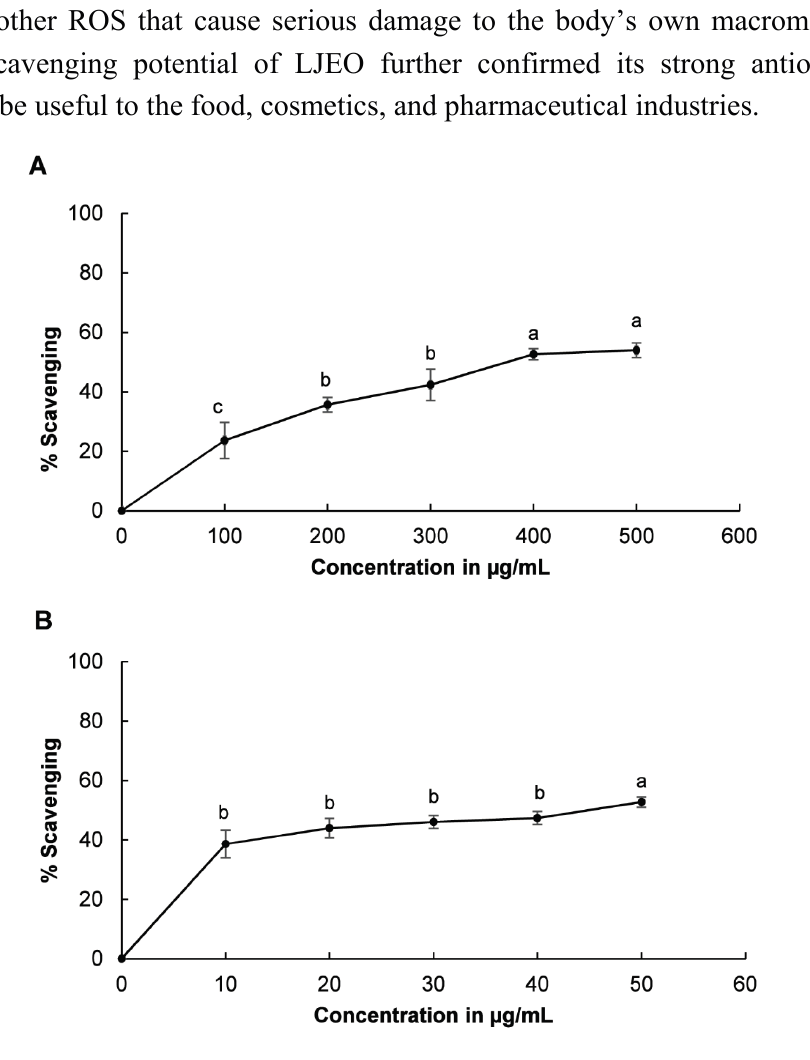
Figure 5. Superoxide scavenging potential of ( A ) LJEO and ( B ) BHT as a reference. The results are the mean value of three independent replicates; values with different superscript letters in each section are significantly different at p <